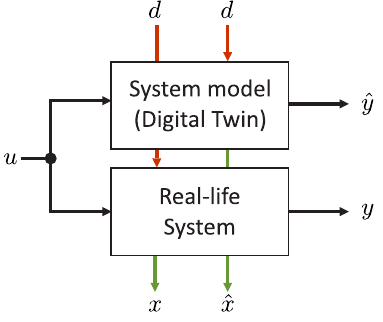
Figure 4. Generic setup for a real-life system and its replication as a digital twin using system